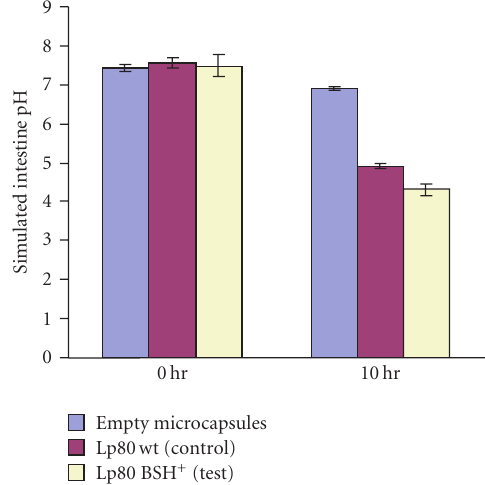
Figure 4: E ff ect of empty microcapsules, microencapsulated L. plantarum 80 wild type (control) cells, and microencapsulated L. plantarum 80 BSH + (test) cells on simulated intestine